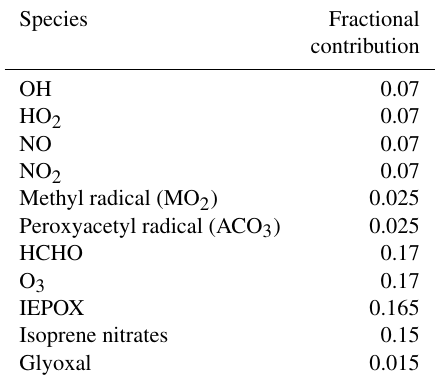
Table 5. Species used in the calculation of the mechanism error metric and their corresponding